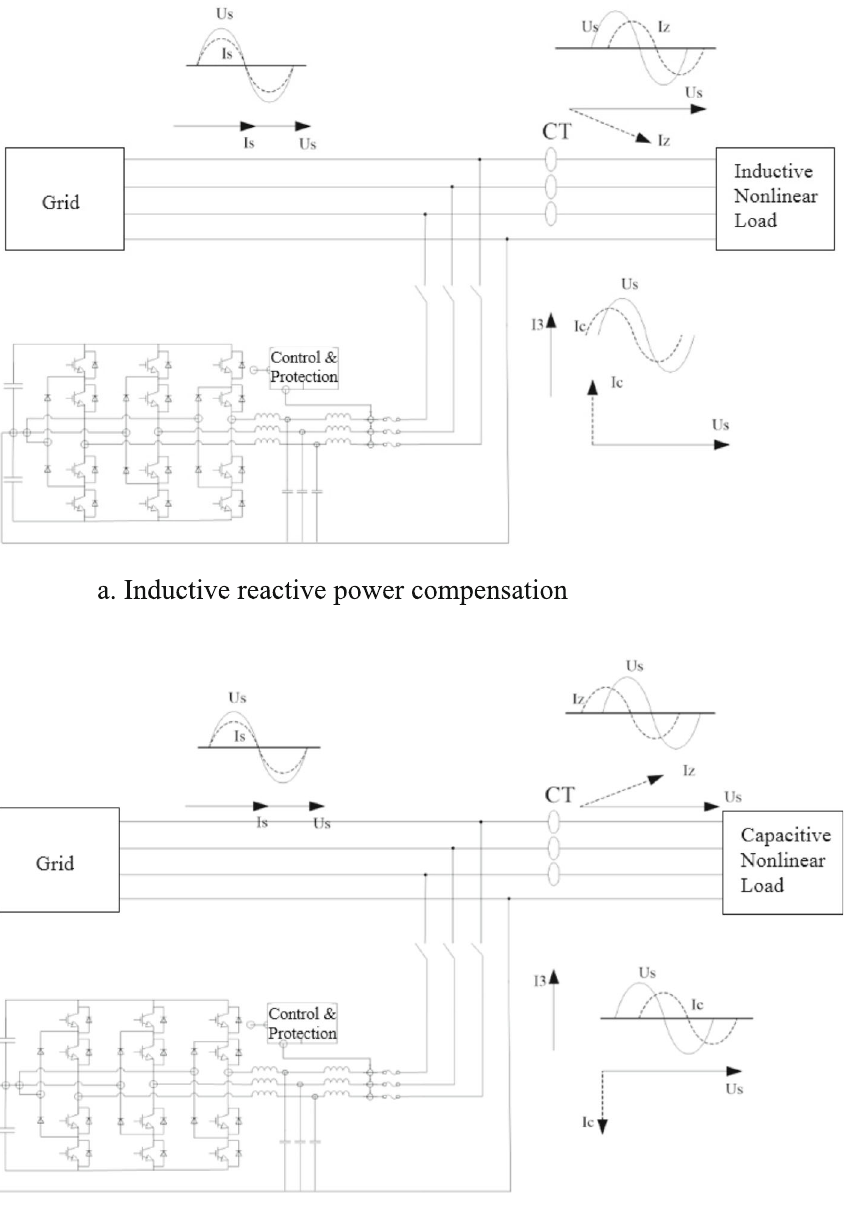
Fig. 4 Principle of SVG reactive power compensation. a . Inductive reactive power compensation. b . Capacitive reactive power